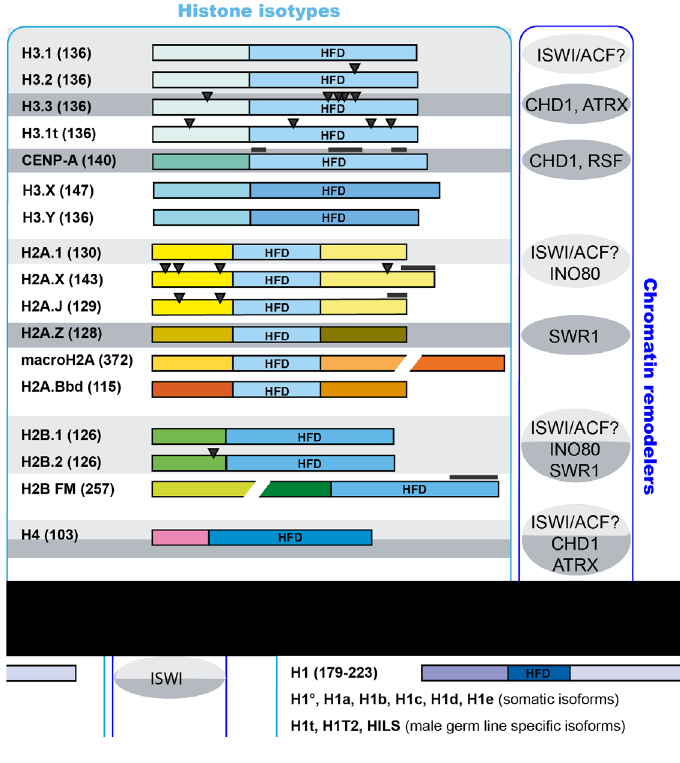
Figure 1. Schematic representation of mammalian histone isotypes (left panel) and of the respective remodeling enzymes that have been linked to their incorporation (right panel). Numbers in parenthesis represent the amino acid sequence lengths of the histone proteins. Identical colors indicate identical amino acid sequences. Replication-coupled histone incorporation is denoted by light grey shading, replication-independent assembly is indicated by dark grey shading